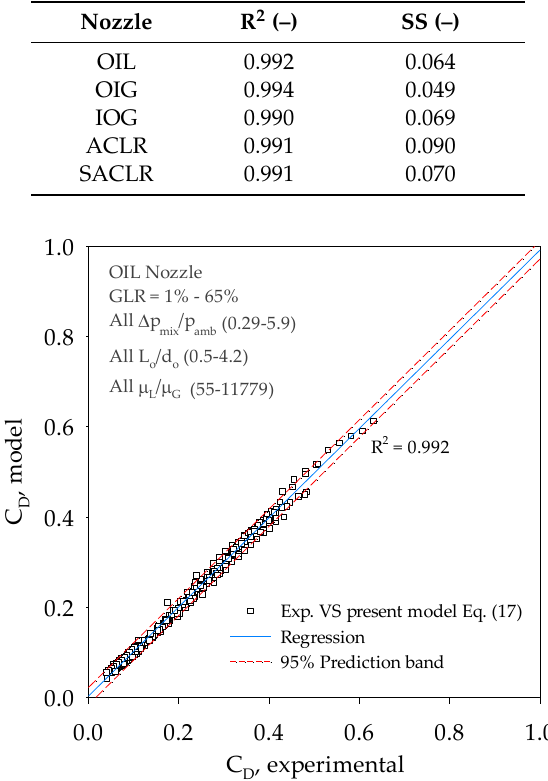
Figure 13. Comparison of the experimental and predicted C D from the present model in Equation (17) for the OIL nozzle. Processes 2020 , 8 , x FOR PEER REVIEW